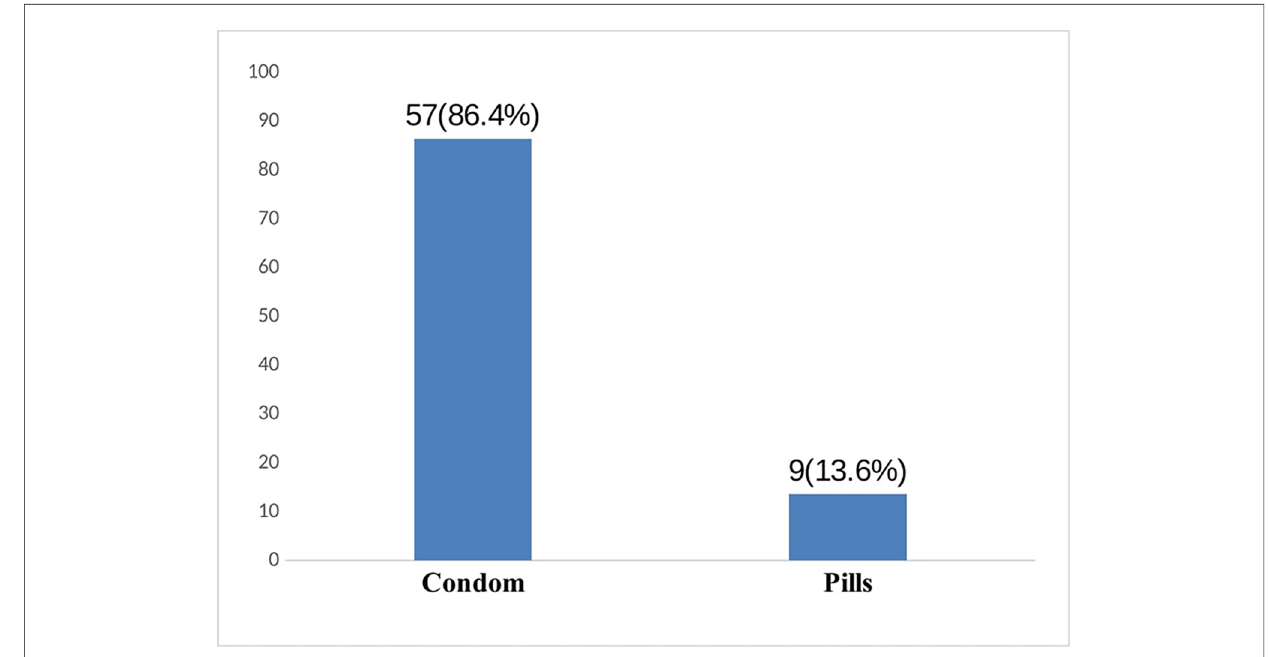
FIGURE 1 Schematic staging of sampling